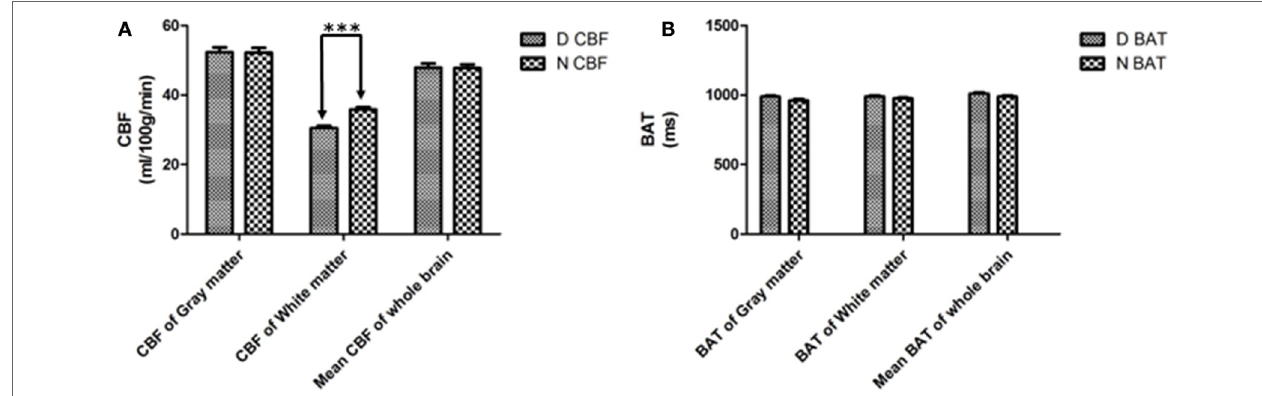
FigUre 1 | Cerebral blood flow (CBF) (a) and bolus arrival time (BAT) (B) of white matter, gray matter and the mean value of the whole brain. D = patients with type 2 diabetes, N = the normal control. *** p < 0.001.